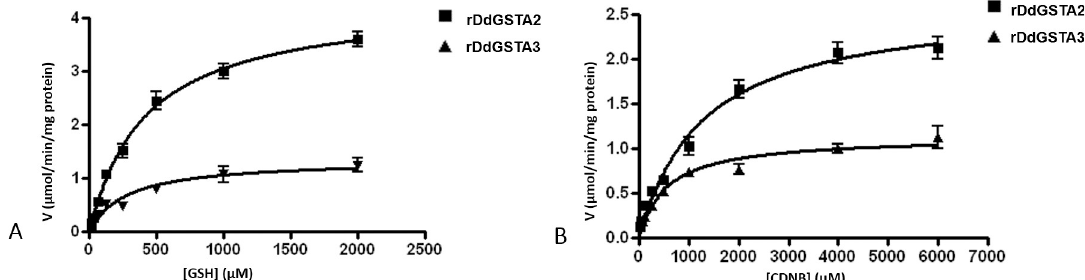
Fig 5. Kinetics of rDdGSTA2 and rDdGSTA3 isozymes. (A) Substrate versus velocity curves for calculation of K m and V max of GSH, for rDdGSTA2 and rDdGSTA3. GST kinetic assay was conducted in presence of saturating concentration of CDNB and different glutathione concentrations (0–2000 μ M). (B) Substrate versus velocity curves for calculation of K m and V max of CDNB, for rDdGSTA2 and rDdGSTA3. GST kinetic assay was conducted in presence of saturating concentration of glutathione and different CDNB concentrations (0–6000 μ M). Data are representative of three separate experiments (n = 3) and are given as mean ± SD (p � 0.05).